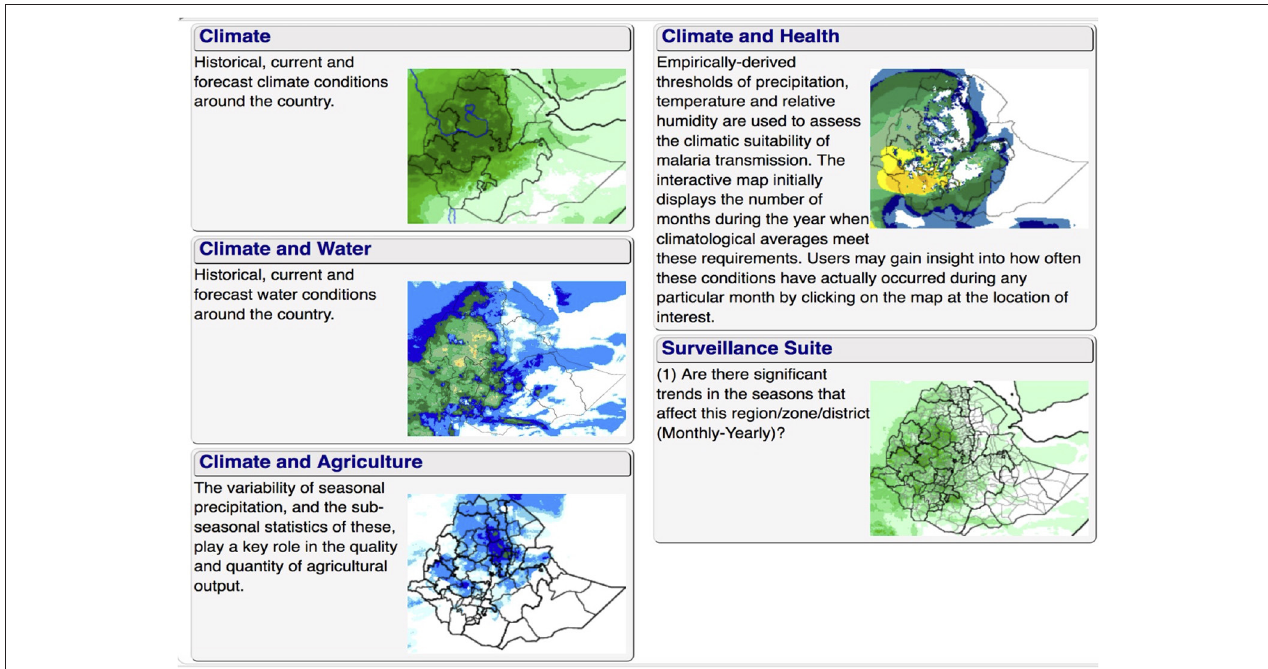
FIGURE 7 | The current version of ENACTS maprooms for one of the advanced ENACTS